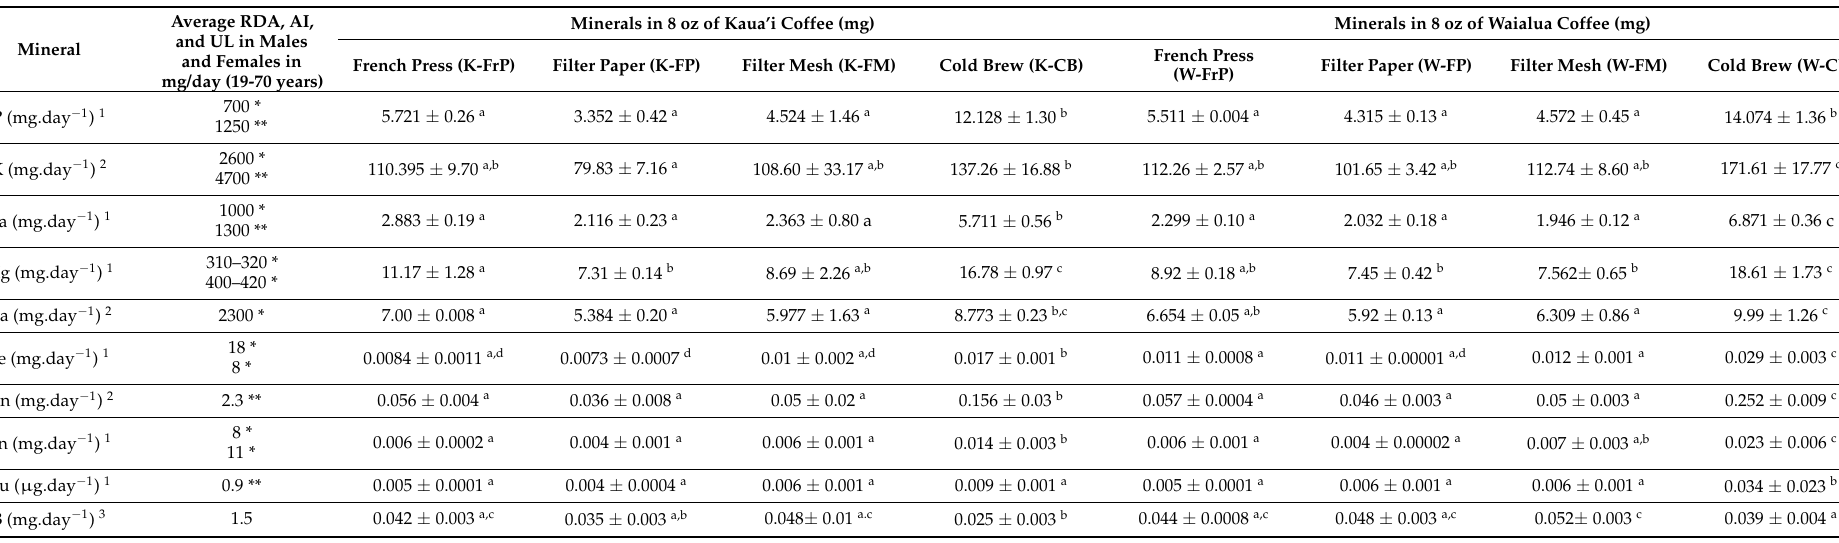
Table 1. Mineral contents of Kaua’i and Waialua coffee prepared by different brewing methods. a,b,c Mean values with common letters do not differ ( p < 0.05).